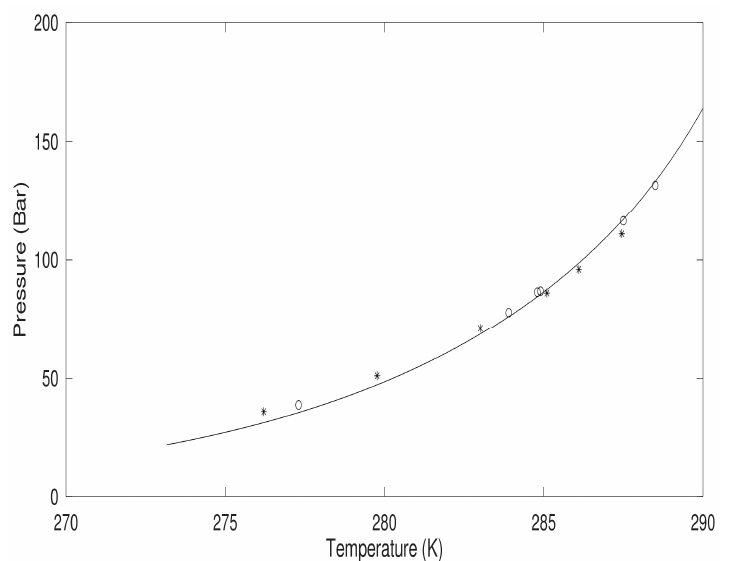
Figure 1. Pressure and temperature hydrate stability limits from calculations (solid curve) and two experimental data sets. * are data from Sabil et al. [12] and o are data from Tumba et al. [13].